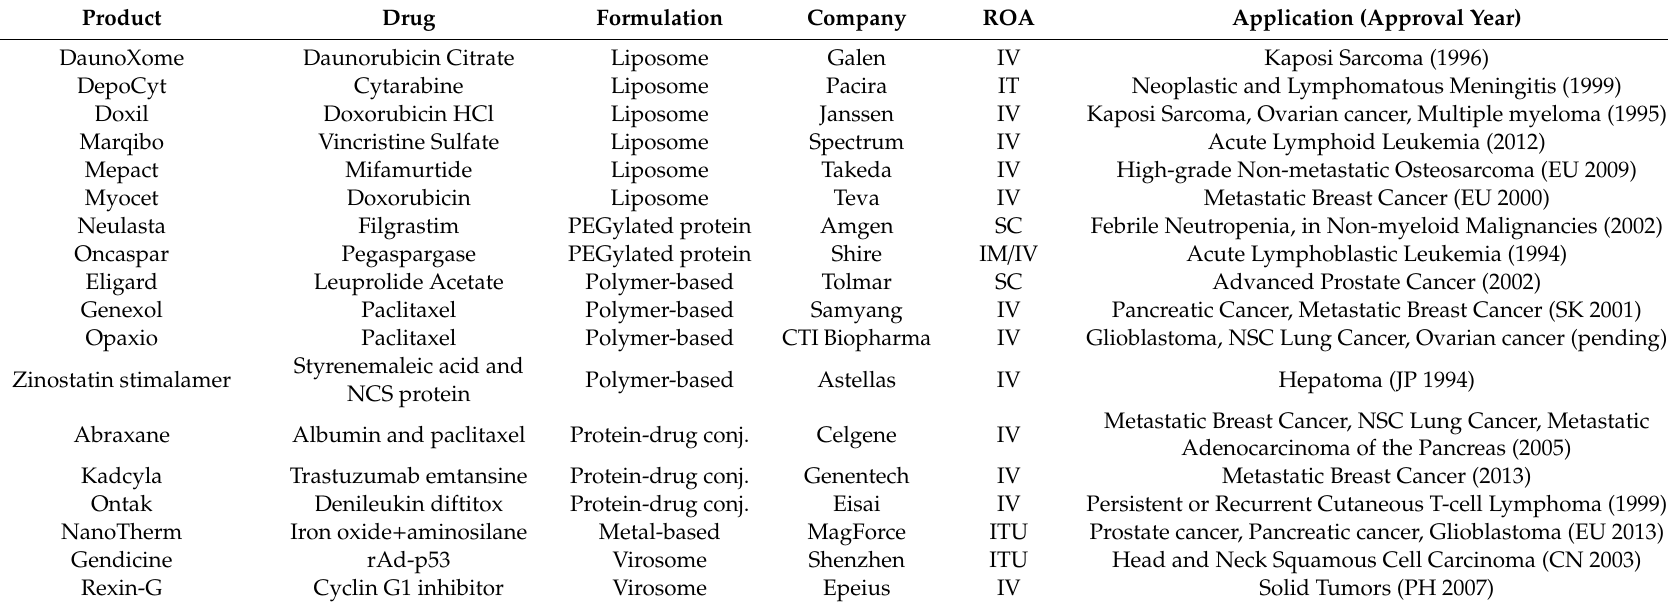
Table 2. Approved oncological nanopharmaceuticals and their